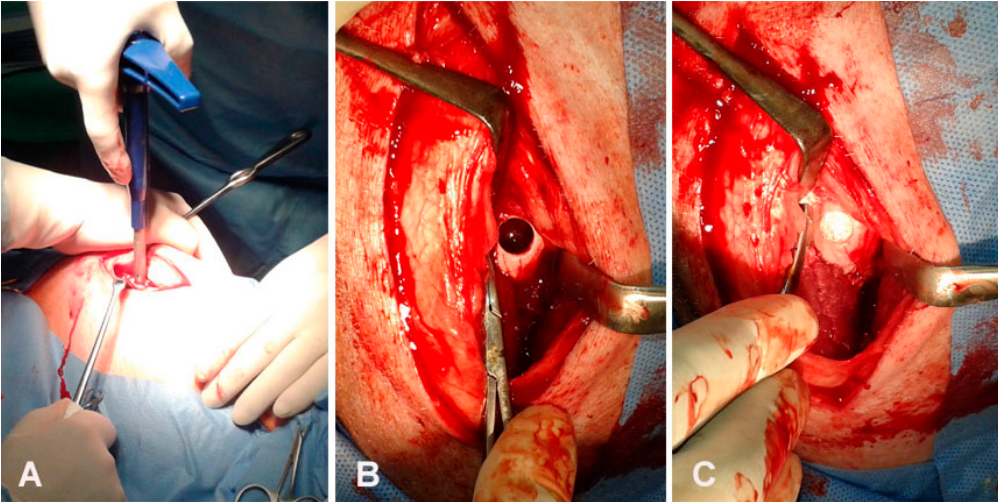
Figure 2. Surgical procedure. ( A ) Inducing of articular cartilage defect with osteochondral autograft transfer system (OATS) equipment, ( B ) Preparing articular cartilage defect in femoral trochlea before implantation, ( C ) Inserting of scaffold into prepared articular cartilage defect.